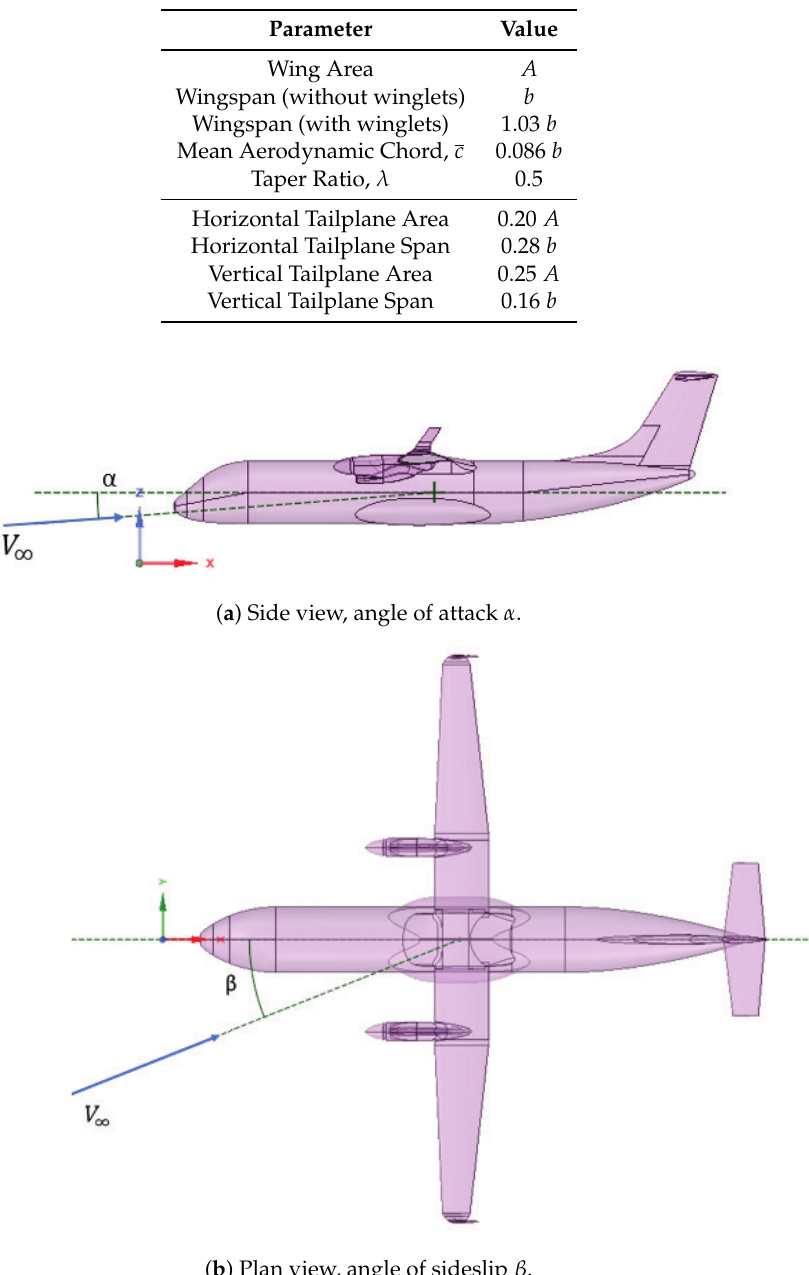
Table 1. Clean wings: geometrical data.